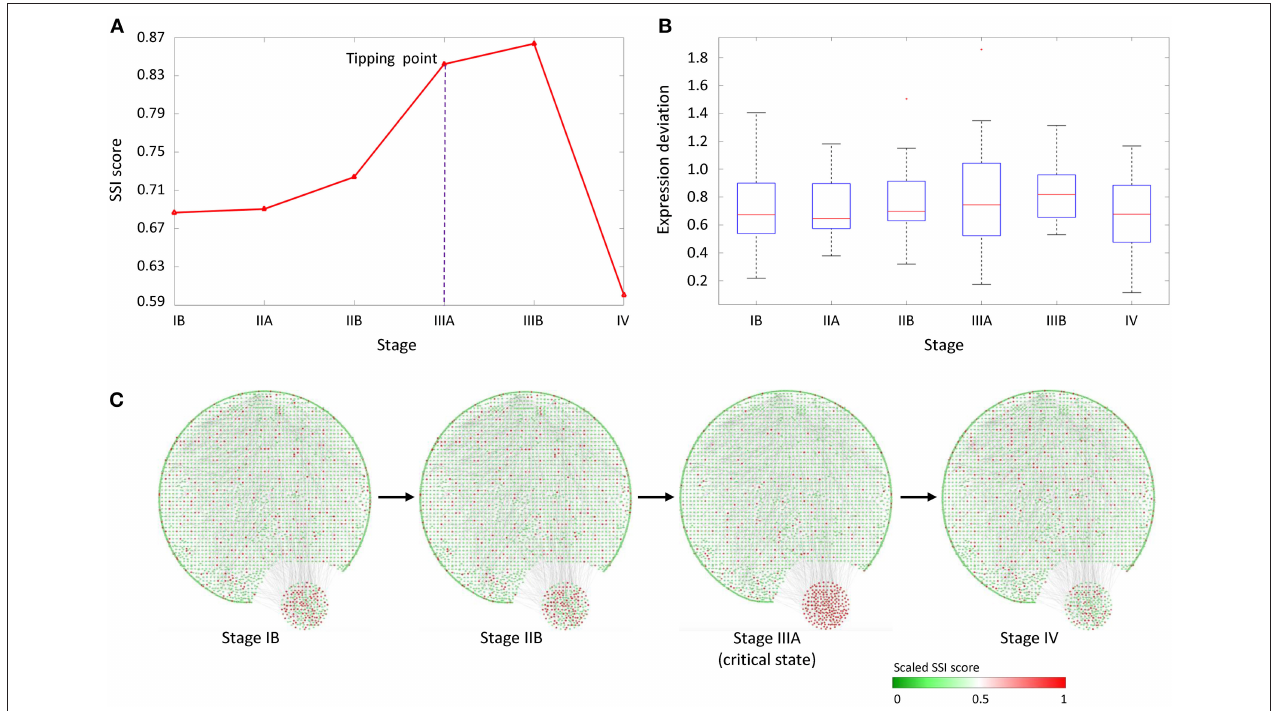
FIGURE 4 | The application of SSI score in STAD dataset. (A) The significant increase of SSI score indicates the tipping point at stage IIIA, before the deterioration into distant metastasis at stage IV. (B) The average expression deviation between each single sample and the reference. (C) The dynamical evolution of the whole gene regulatory network. The top 1% genes with the largest local SSI scores were arranged at the right-bottom corner.